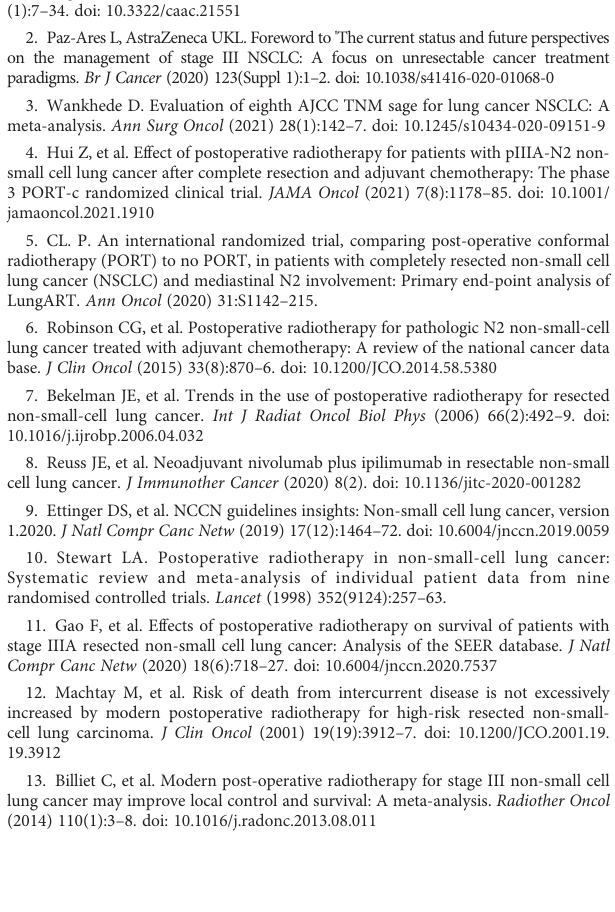
SUPPLEMENTARY FIGURE 1 Cumulative incidence estimates of stage IIIA-N2 NSCLC patients by key characteristics after PSM. The observed event are death from the lungs from (A – C) and the observed event are death from the lungs in right laterality from (D – F) . Categorical variables including S1A: sex; S1B: age; S1C: tumor stage; S1D: sex; S1E: age; S1F: tumor stage. SUPPLEMENTARY FIGURE 2 Forest plots displaying the relationship between the PORT group and the non-PORT within the different